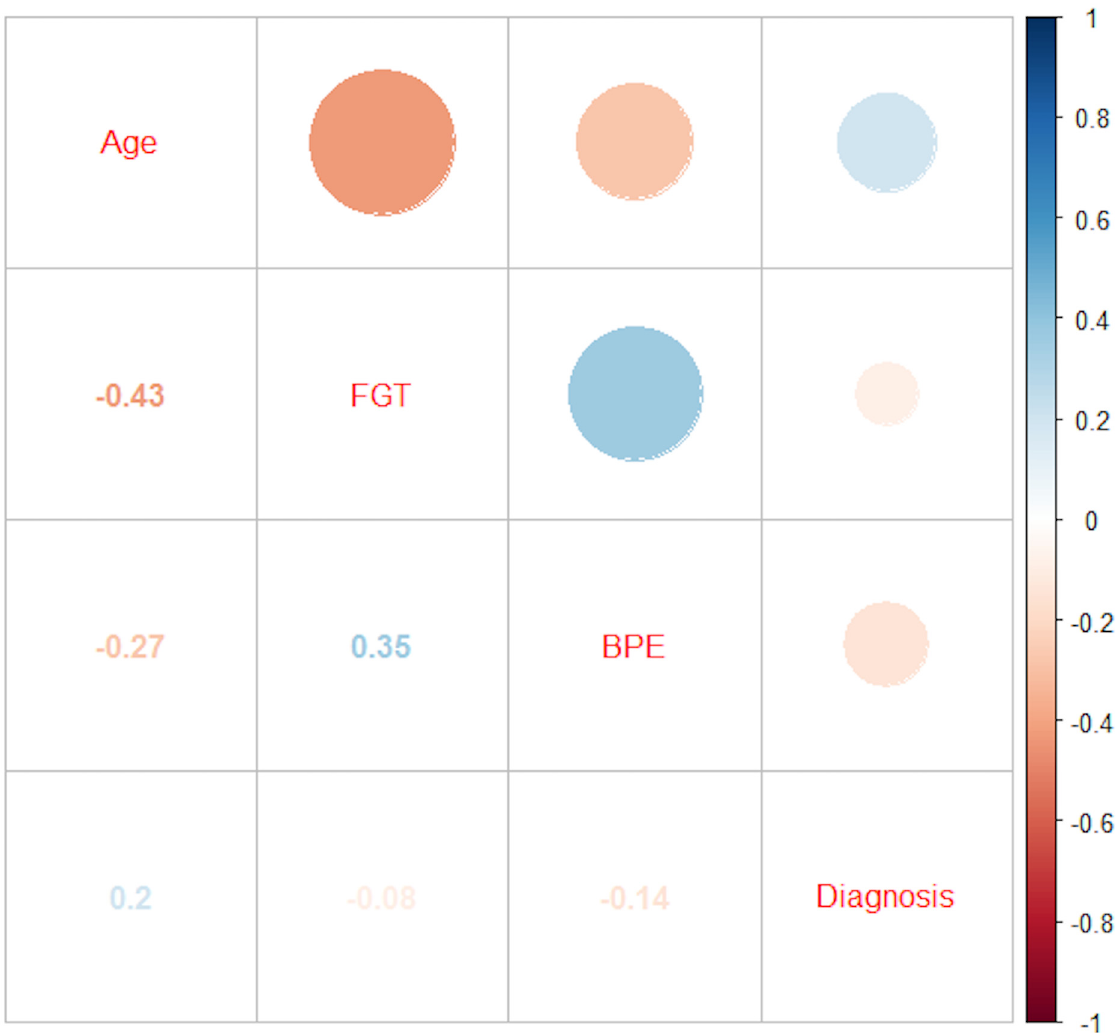
Fig 1. Color-coded correlation matrix of Spearman ’ s rank correlation coefficients. Blue indicates positive, whereas red indicates negative correlations. Size corresponds to strength of correlation. Correlation coefficient values are mirrored in the lower left quadrant. All values were statistically significant (p <